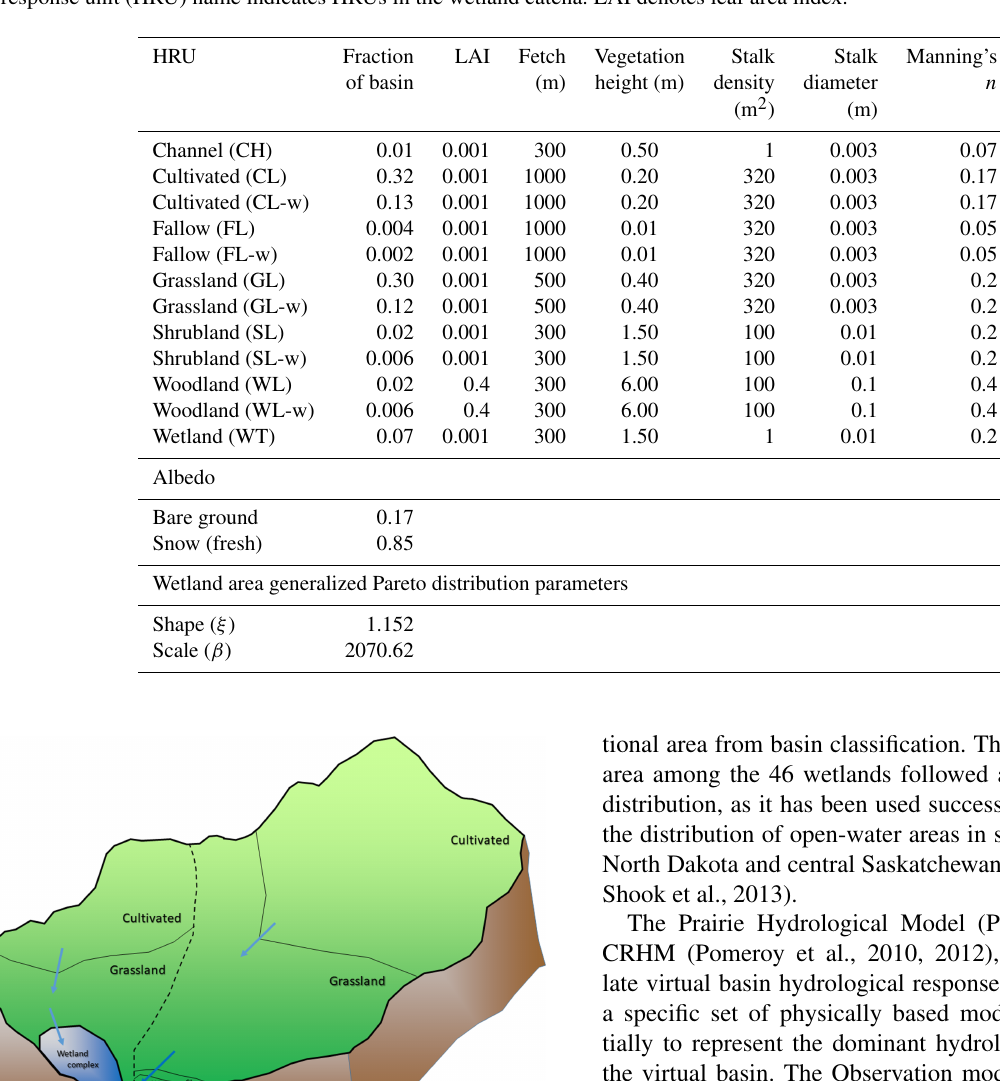
Table 1. Cold Regions Hydrological Model parameters for the High Elevation Grassland virtual basin model. The suffix “-w” in the hydro-